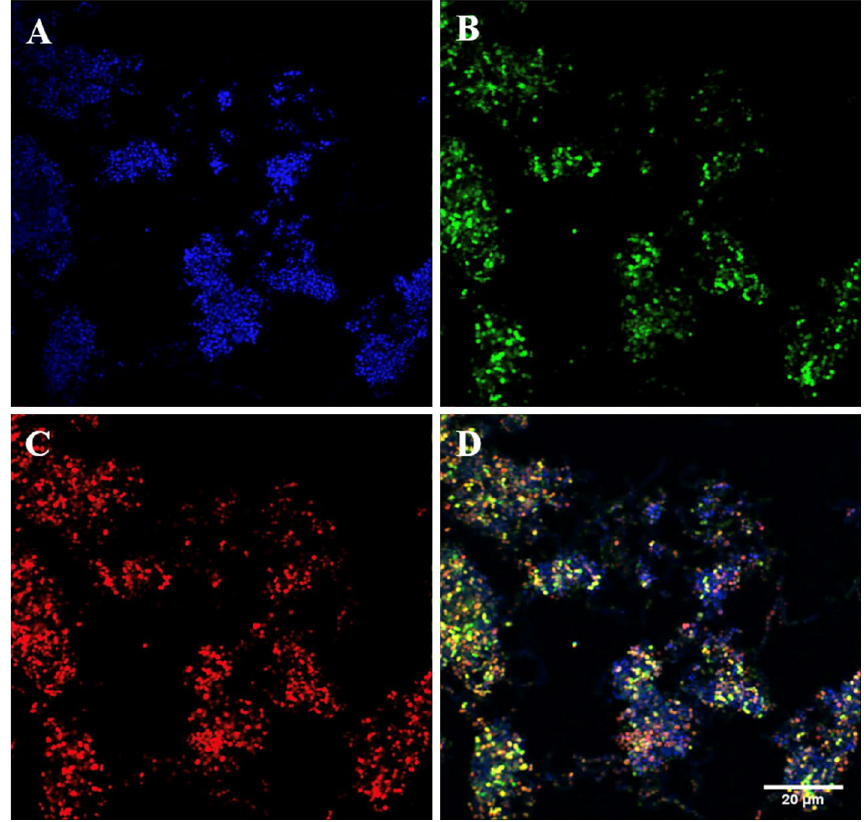
Figure 1. Fluorescence in situ hybridisation staining of pure Streptococcus pyogenes ATCC 700294 cells from broth culture. ( A ) DAPI in blue identifying all of the nucleic material present, ( B ) Eubacterial probe (EUB) in green identifying all of the bacterial present, ( C ) Streptococcus spp . specific probe (STRC493) in red highlighting all of the Streptococcus spp. present, ( D ) Composite image of figure ( A – C ). Images at ×60